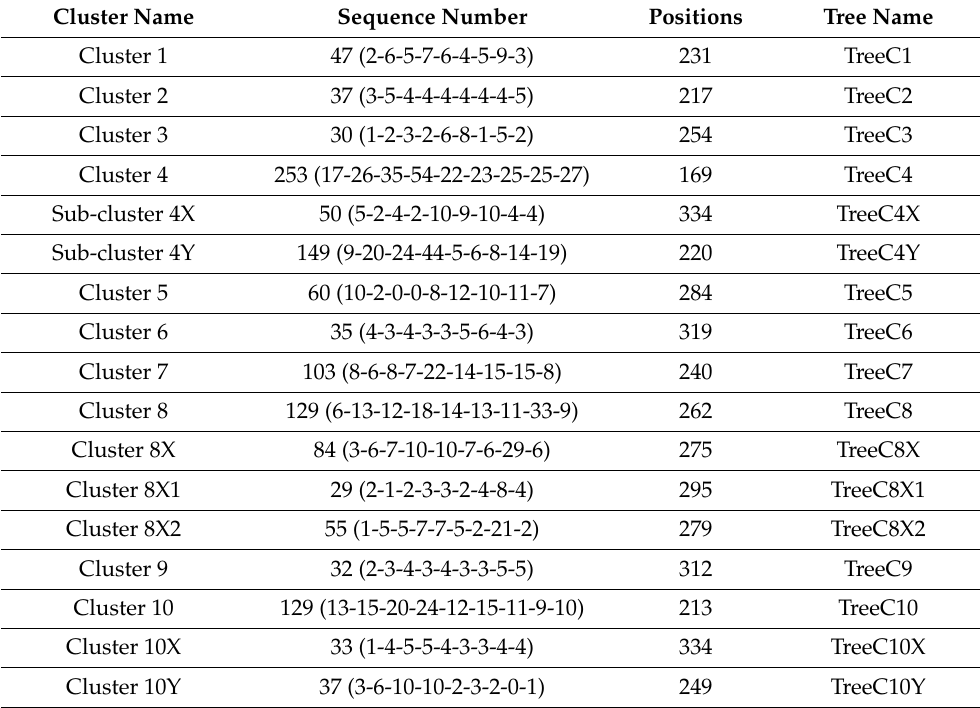
Table 2. Overview of cluster analysis to establish